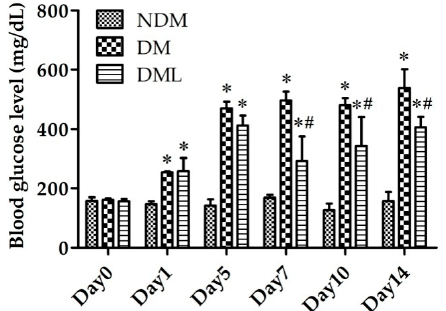
Figure 1. Luteolin ameliorated blood glucose levels in STZ-induced diabetic rats. Changes in blood glucose in STZ-induced diabetic rats supplemented with luteolin during 14-day experimental period. Values of individual groups are presented as mean ± SEM. * p < 0.05, compared with NDM group. # p < 0.05, compared with DM group. NDM, non-diabetes mellitus; DM, diabetes mellitus; DML, diabetes mellitus treated with luteolin 100 mg/kg body weight, ip.